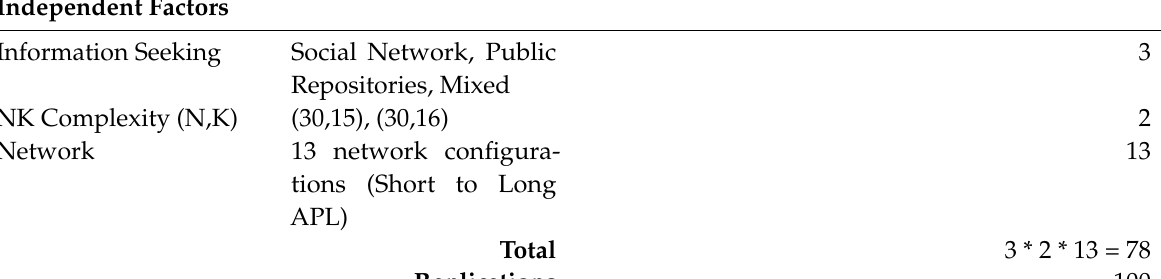
Table 1: Summary of the knowledge transfer model. Independent